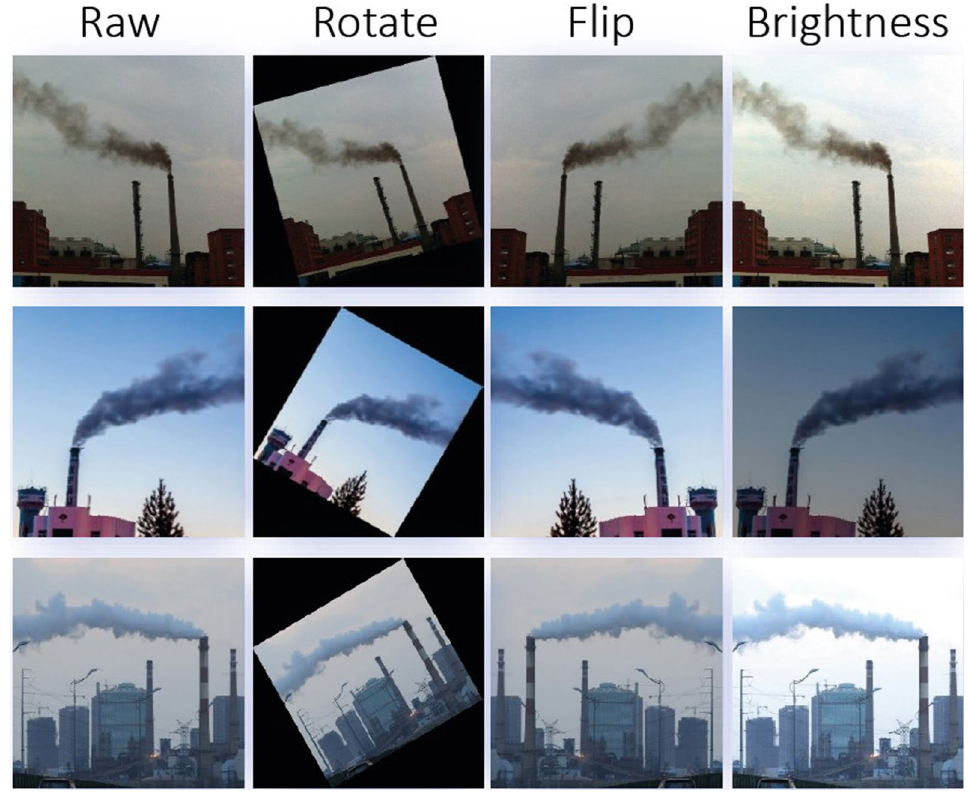
Figure 6. Examples of data augmentation. It includes three kinds of augmentation strategies. The first column is the raw data. The second column is to rotate the image, the third is to flip, and the fourth is to transform